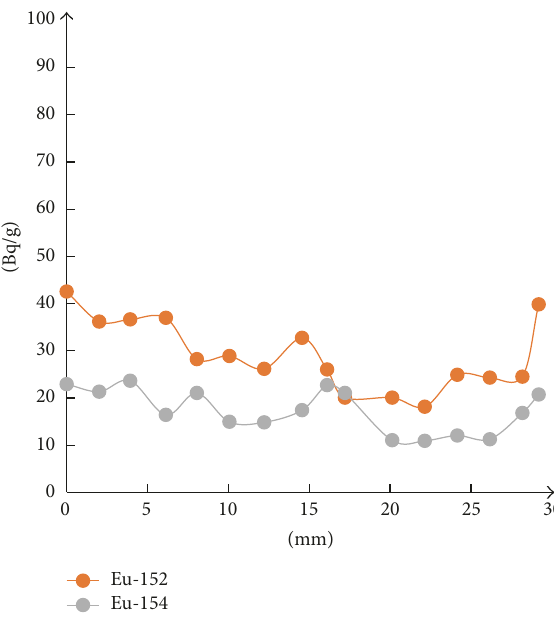
Figure 9: Distribution profiles of Eu-152 and Eu-154 activities at different spherical radii in the selected graphite sphere.